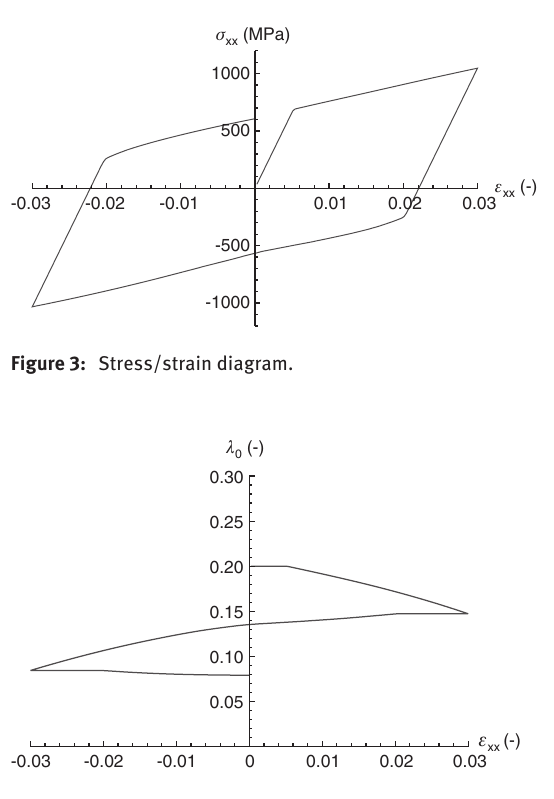
Figure 4: Development of effective austenitic volume fraction.